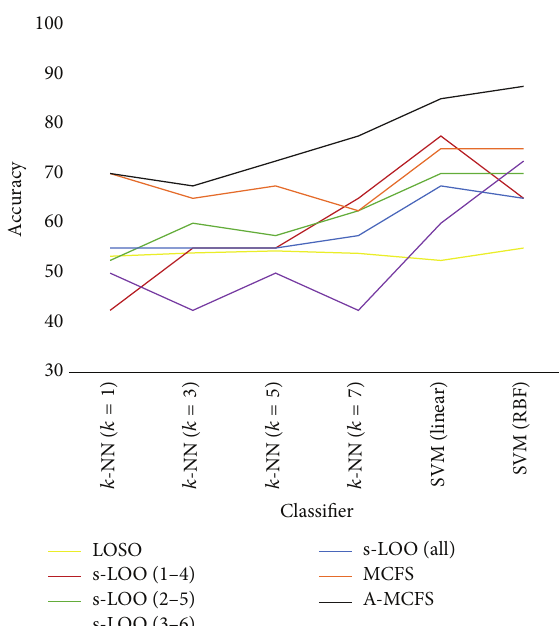
Figure 3: Obtained accuracies based on the reported results in Table